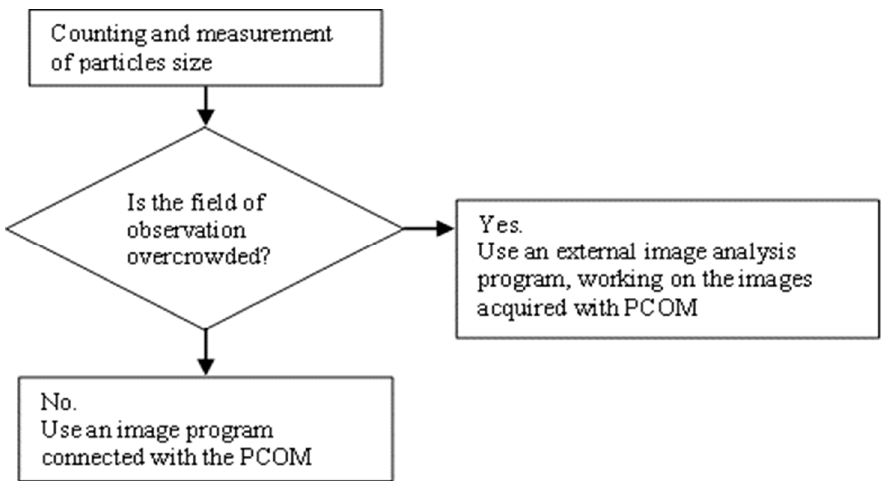
Figure 4. Decision-making process for particle counting and measurement on phase contrast optical microscope (PCOM). Relationship with the field of observation overcrowding.